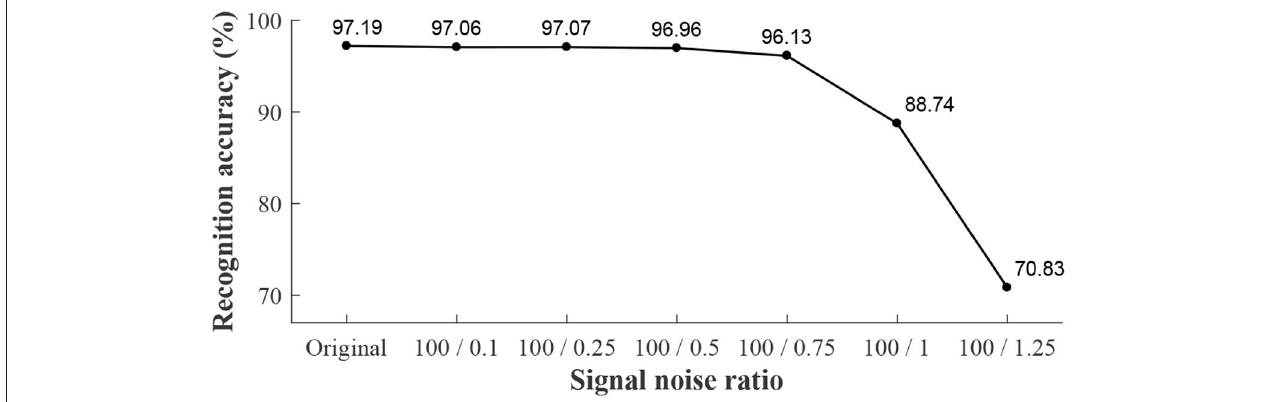
FIGURE 9 | Robustness analysis (off-line) of recognition for locomotion modes. The horizontal axis denotes the signal noise ratio, which represents the noise added by manual into original data. Here, “Original” denotes the original data without added noise. The text in this figure denotes the recognition